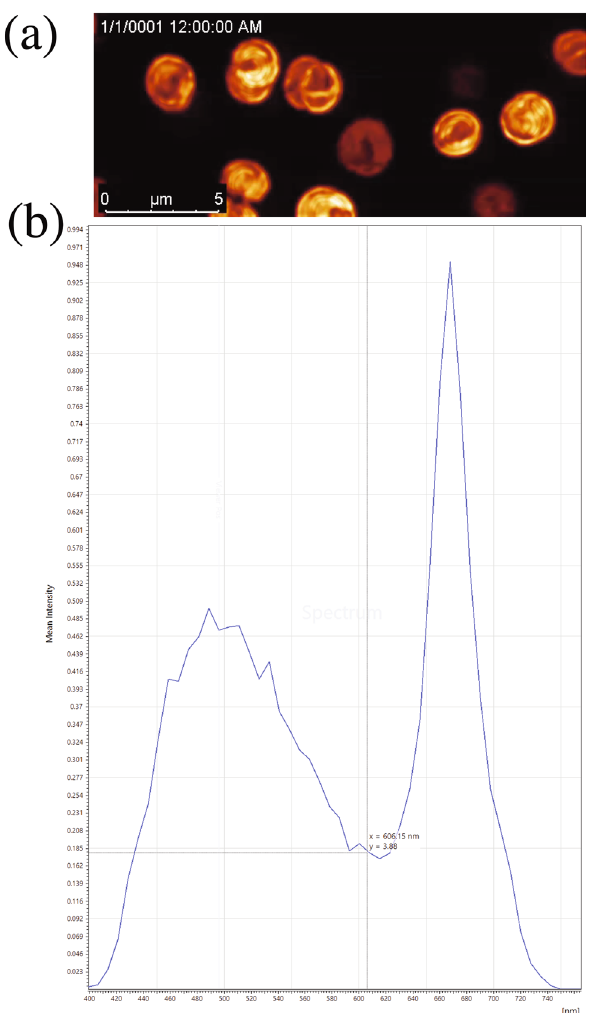
Figure 1. ( a ) Time-lapse video microscopic images of Synechocystis sp . PCC 6803, and ( b ) its fluorescence emission spectra analysis. Red color indicates the abundance of photosynthetic pigments.